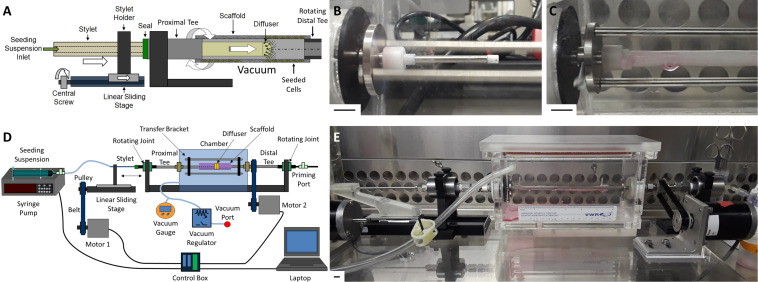
Overview of translating-rotating seeding device. (A) Schematic of the linear sliding stage system used to translate the Stylet/Diffuser component within the rotating scaffold lumen during seeding under vacuum. (B) Image of the Stylet/Diffuser system emerging from the proximal mounting tee. (C) Image of a mounted scaffold with the Diffuser infusing cell suspension within the scaffold lumen. (D) Schematic and (E) image of the novel cell seeding device developed in this study to bulk seed human-sized tubular scaffolds. Scale bars depict 1 cm.